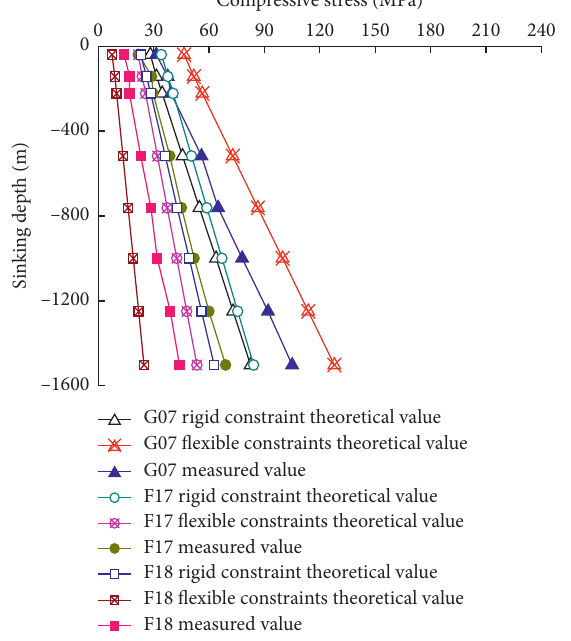
Figure 13: Variation curve of member stress with sinking depth under different restraint